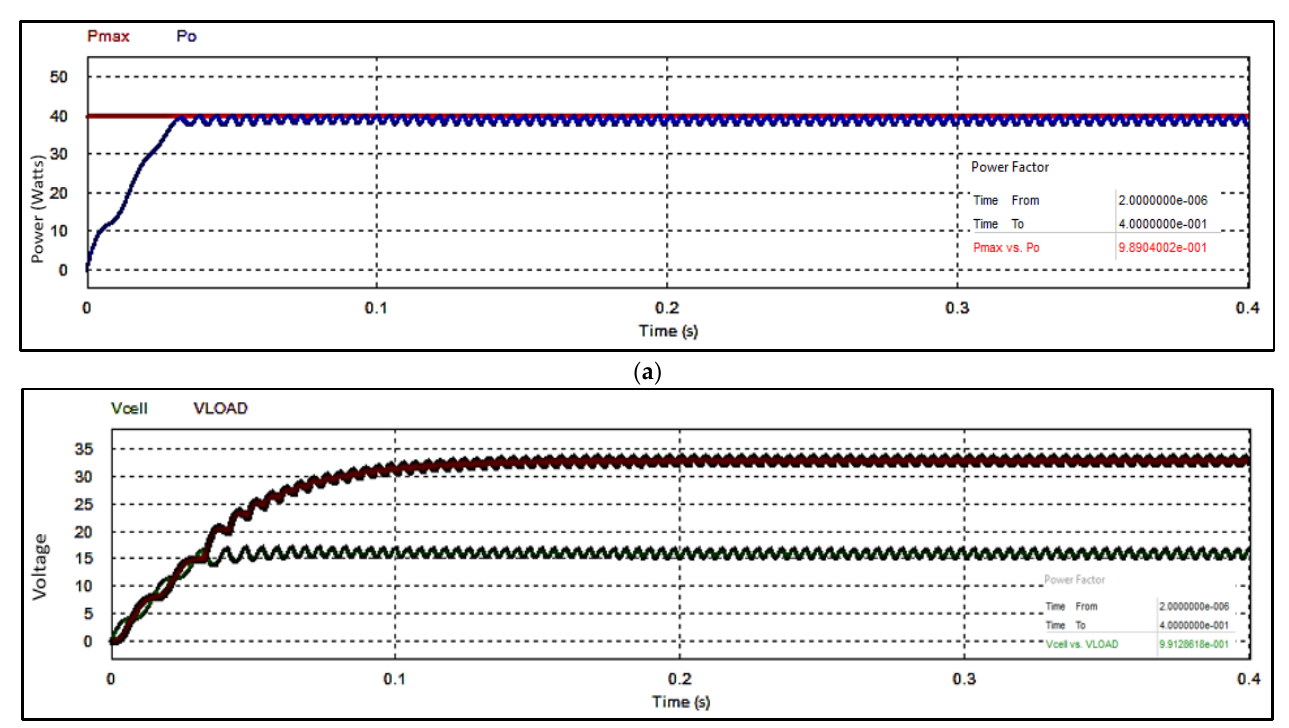
Figure 12. ( a ) PSIM-based simulation of DC-(P&O) method; ( b ) MATLAB Simulink-based DC- (P&O) model.